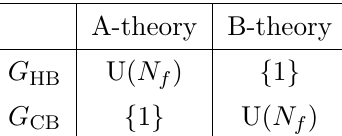
Figure 6. Mirror quiver of SU( N ) with N f = 2 N + k flavors.